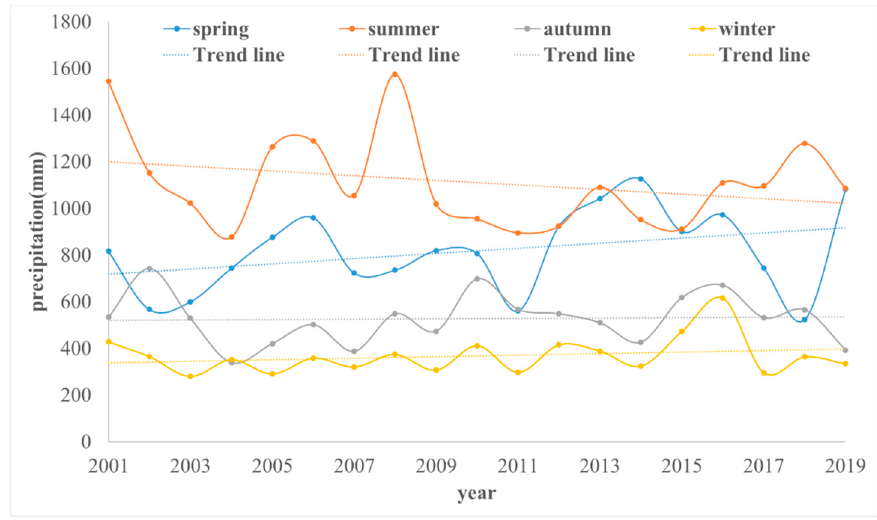
Figure 11. Total precipitation in the four quarters from 2001 to 2019.